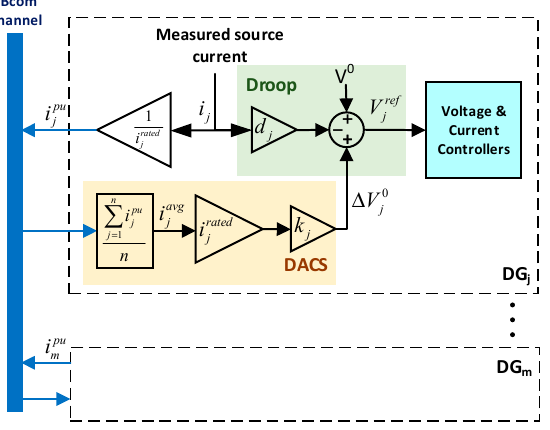
Figure 12. Block diagram of the control method introduced in [108].